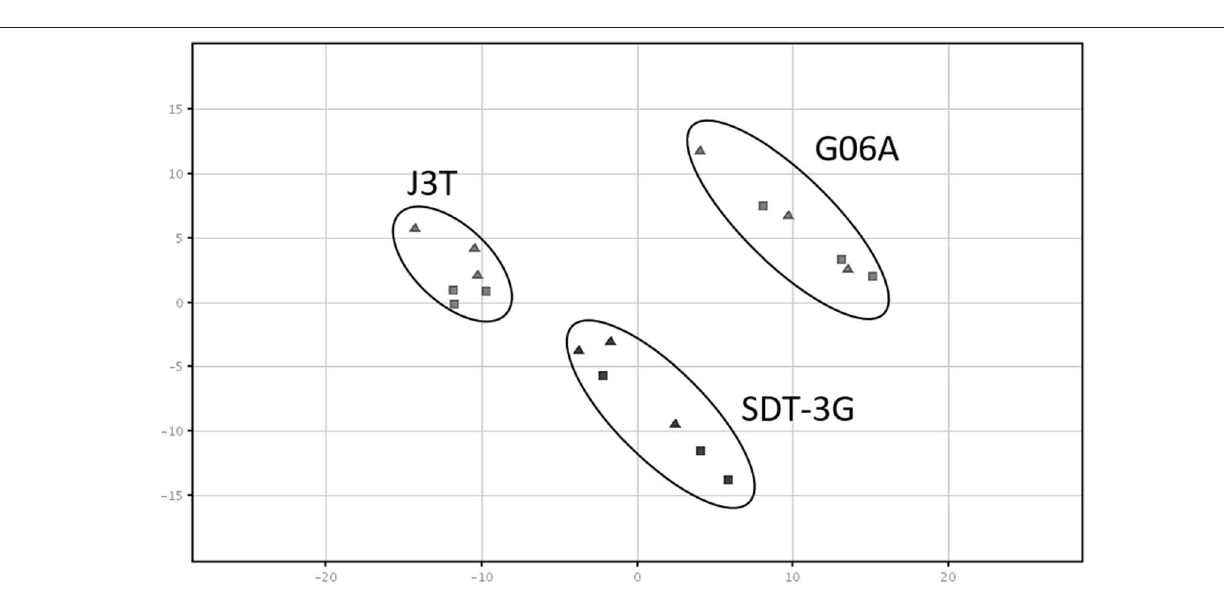
known to be involved in cancer biology, progression, metastasis, or acquisition or maintenance of a stem-like